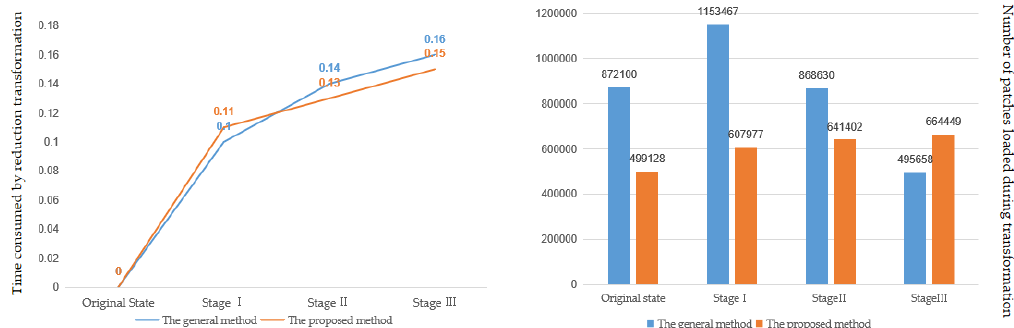
Figure 12. Comparison between the general method and the proposed method.